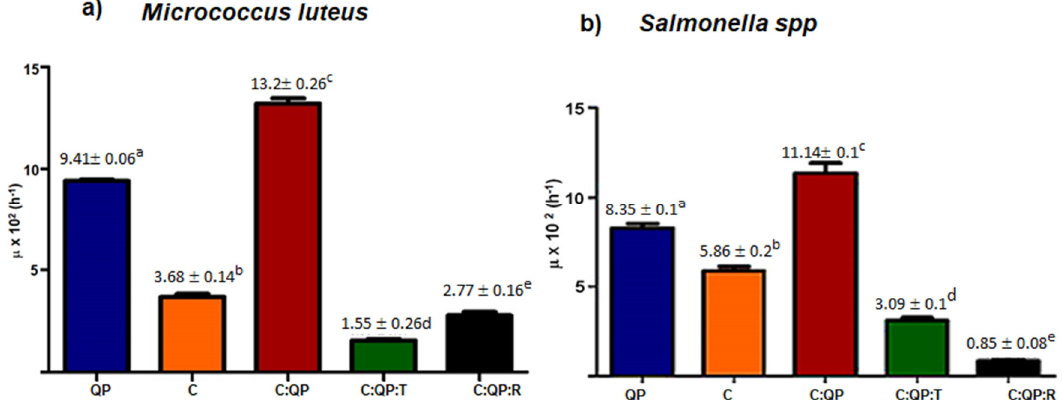
Figure 3. Effect of biopolymers alone, combined, and incorporated with EOs on the specific growth rate of ( a ) Micrococcus luteus ; ( b ) Salmonella sp. µ : specific growth rate; QP: quinoa protein; C: chitosan; T: thyme essential oil 0.5% ( v / v ); R: rosemary essential oil 1% ( v / v ). Data are presented as the mean ± standard deviation. a-e Indicate significant difference ( p < 0.01).